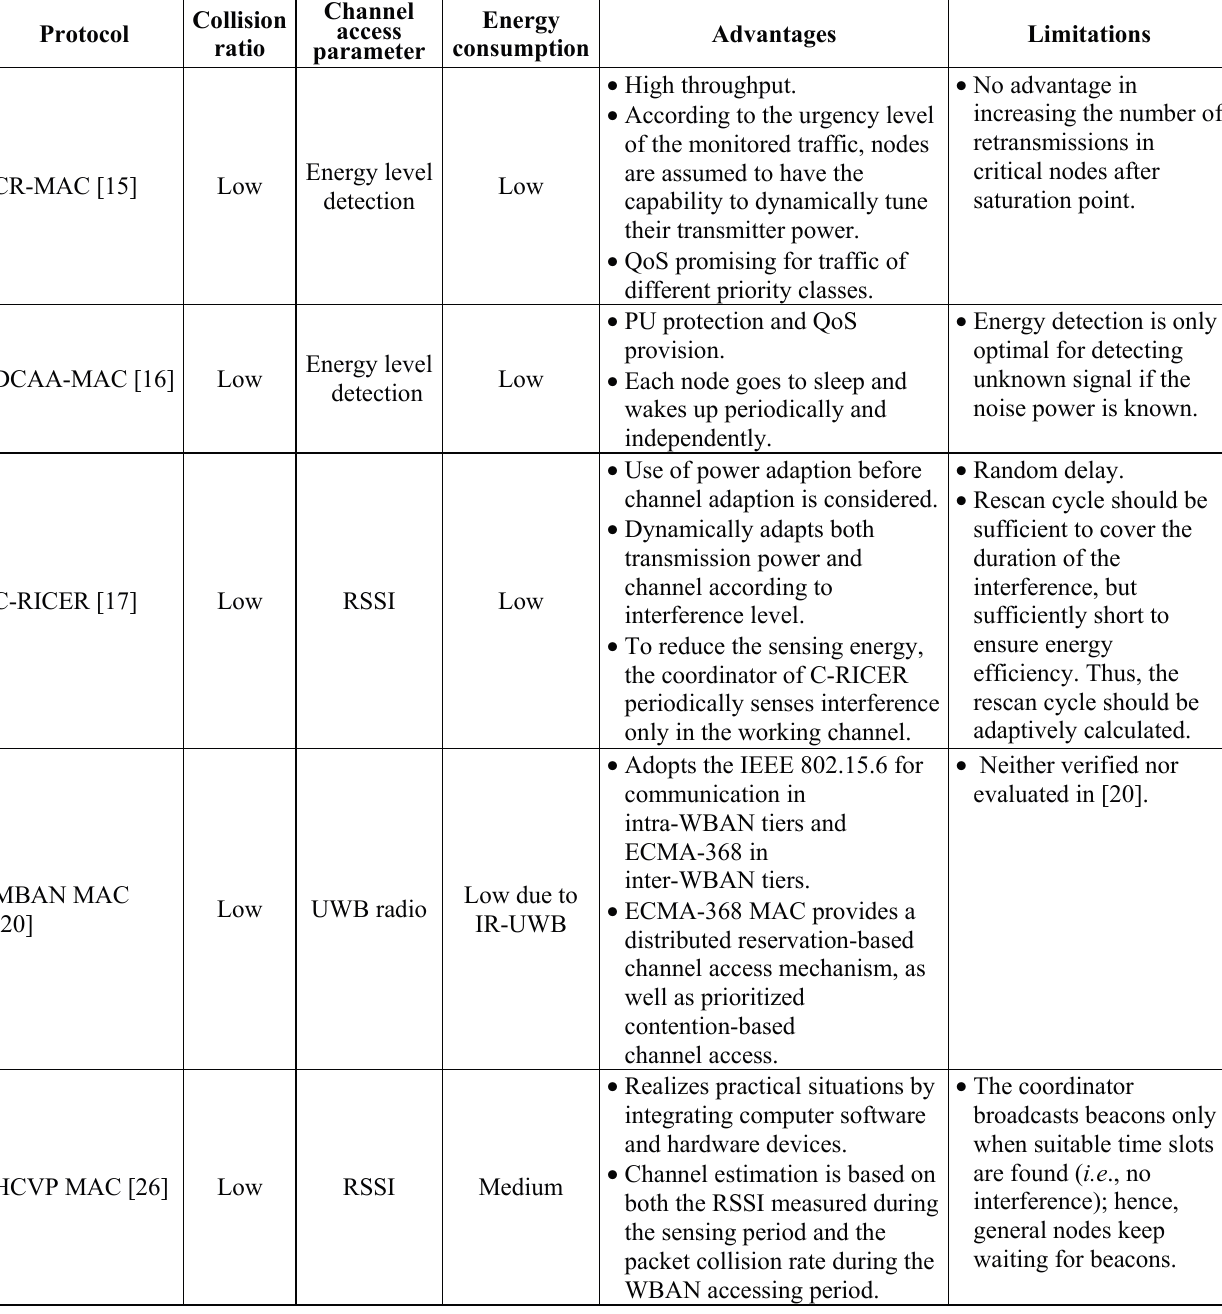
Table 1. Comparison of MAC protocols designed for CRBANs. DCAA, dynamic channel adjustable asynchronous; PU, primary user; MBAN, medical body area network; UWB, ultra-wideband; ECMA, European Computer Manufacturers